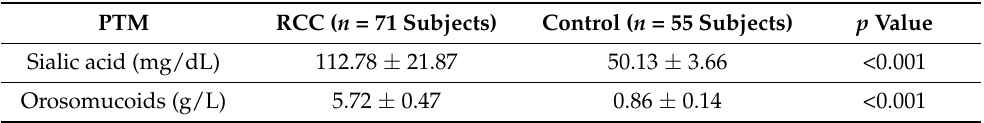
Table 1. Glycosylation status in the studied groups.